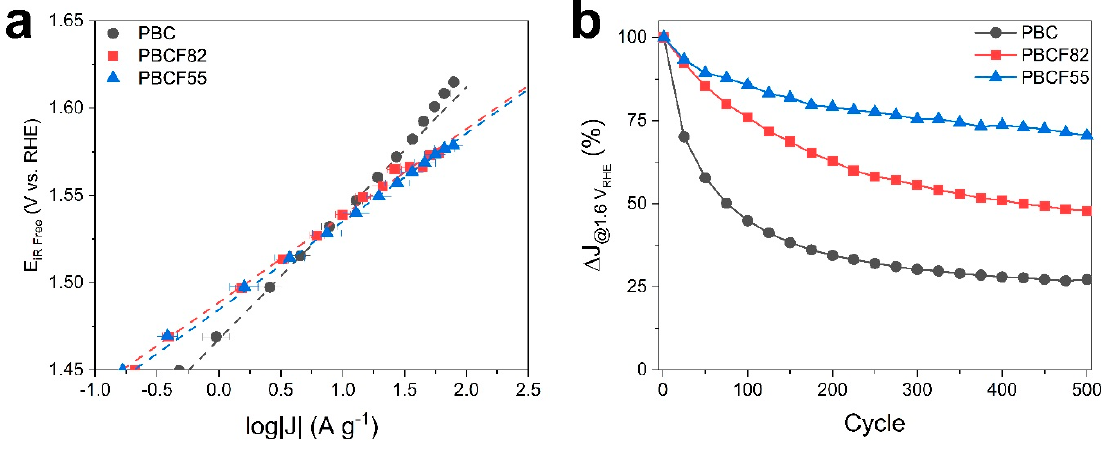
Figure 3. Electrochemical study comparing ( a ) Tafel plot of oxygen evolution reaction activities and ( b ) change in current densities with respect to the initial current density at every 25 cycles over 500 cycles between 1.0 and 1.6 V RHE of PBC (black), PBCF82 (red), and PBCF55 (blue).